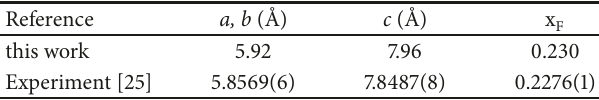
orbitals x 2 - y 2